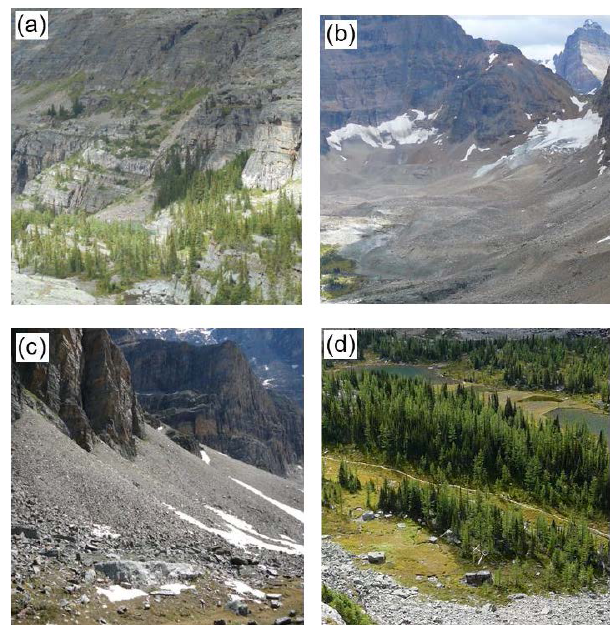
Figure 2. Major hydrogeological response units in the Lake O’Hara watershed. (a) Exposed bedrock. (b) Proglacial moraine. (c) Talus. (d) Alpine